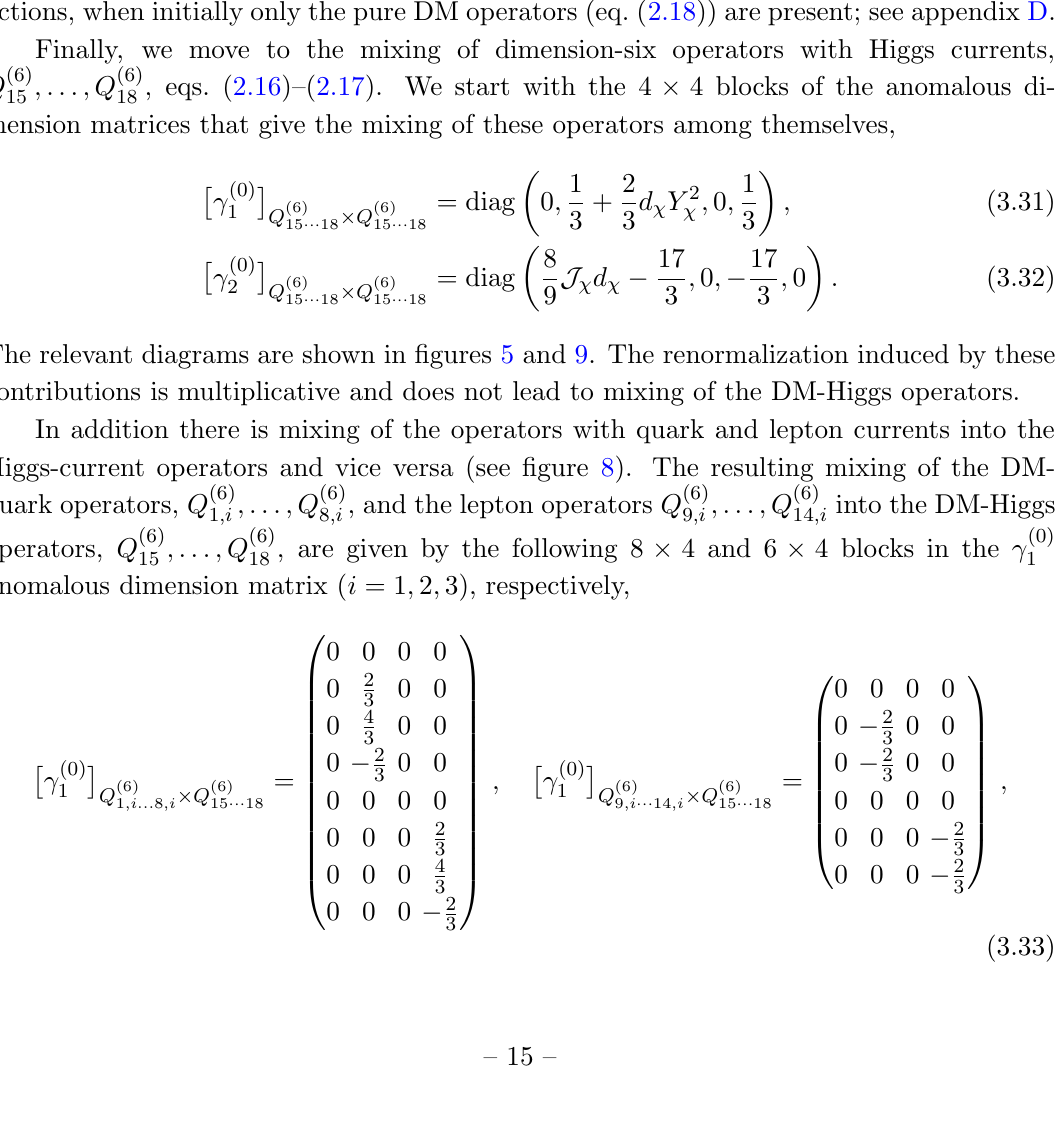
Figure 9 . Additional diagrams for the renormalization of the Q (6) These diagrams are in addition to the set of diagrams in (cid:12)gure 5 which, at dimension six, include an additional derivative w.r.t. to the dimension-(cid:12)ve